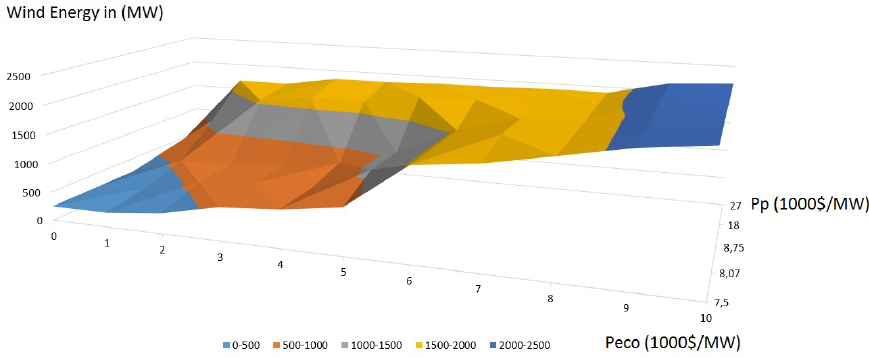
Figure 5. Variation of the optimal wind energy contract capacity with respect to P eco and P p in case of certainty (own results).